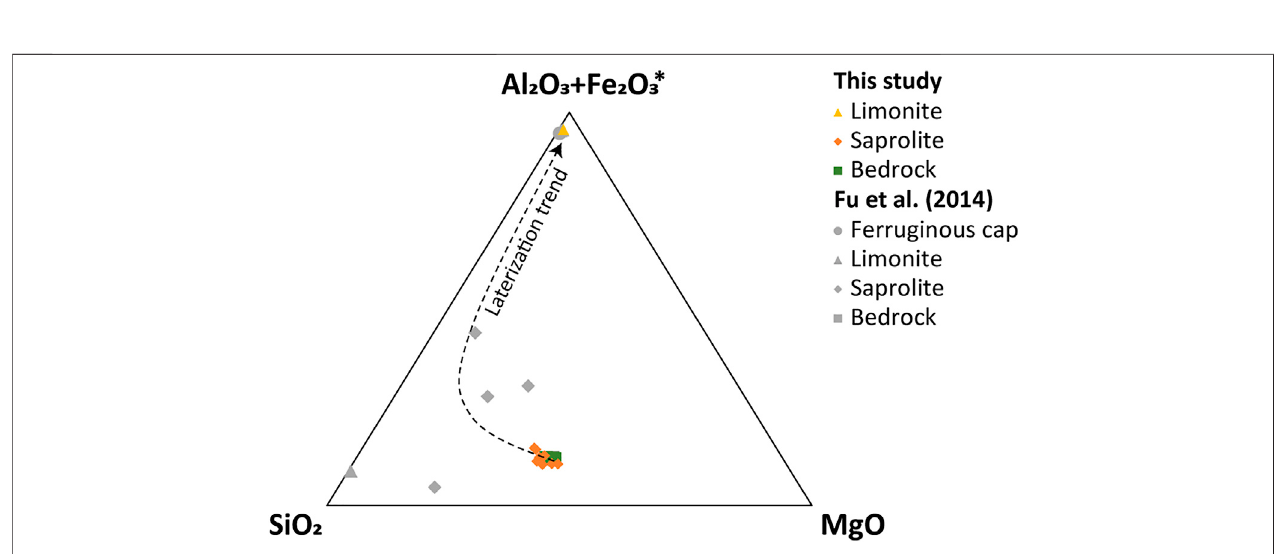
FIGURE 8 | Ternary diagram of Al 2 O 3 +Fe 2 O 3 *-SiO 2 -MgO system for the laterite horizon in the Morowali deposit. Samples from this study are described in colored symbols and references from Indonesia (Fu et al., 2014) are represented by grey symbols. Fe 2 O 3 * means total iron oxide.